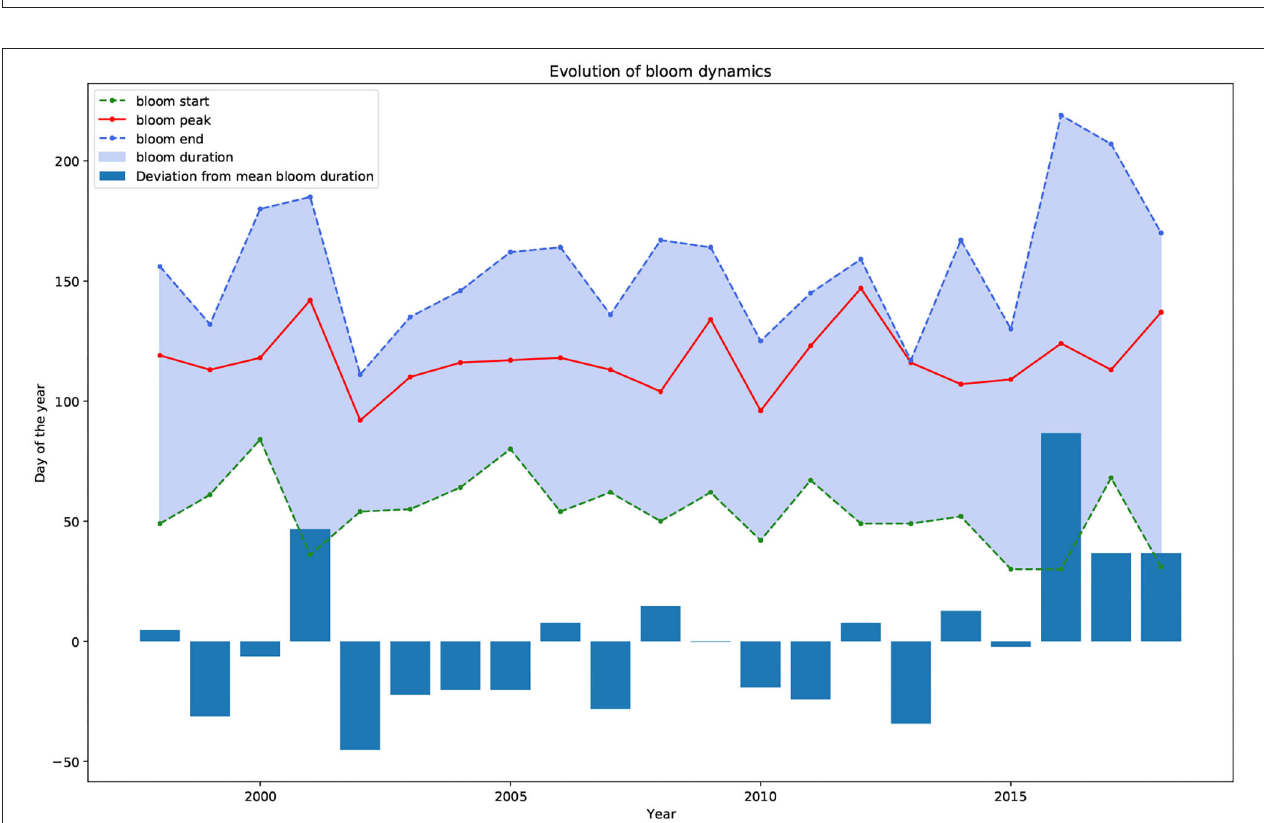
FIGURE 12 | Historical spring bloom cardinal dates (beginning—green, peak—red, end—blue) and bloom duration (shaded blue area). The bar chart shows the yearly deviation (anomaly) from the long-term mean bloom duration.